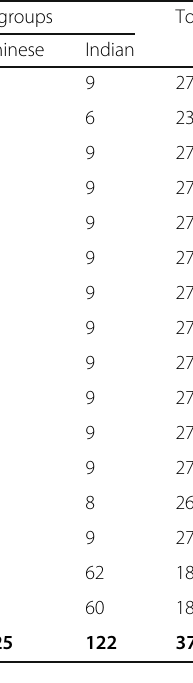
Table 1 Subject distribution across sex, age and